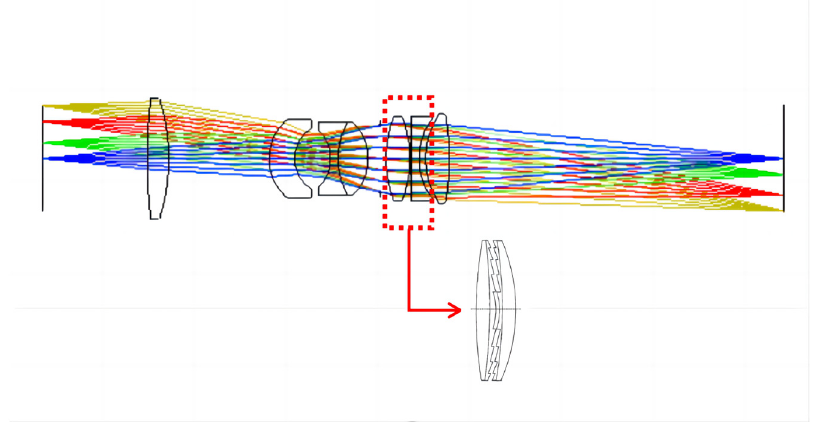
Figure 1. Refractive/diffractive hybrid lens system with double-layer DOEs.